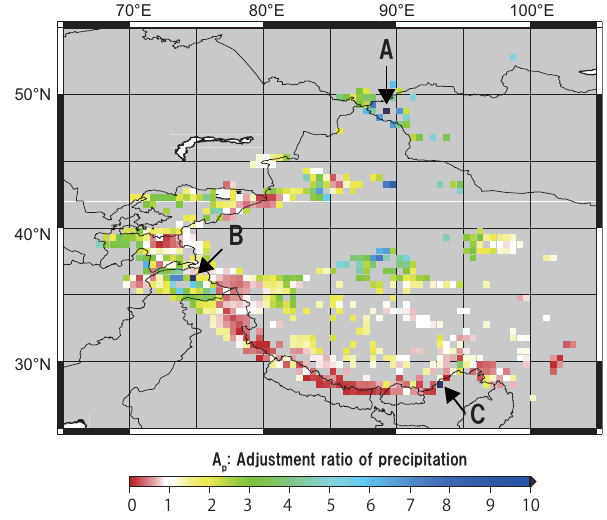
Figure 12. Distribution of the adjustment ratio of P W to APHRODITE precipitation in each 0.5 ◦ grid. Grids with adjust- ment ratio between 0.9 and 1.1 are indicated by white. (A), (B), and (C) indicate grid cells with large A p ( > 10).